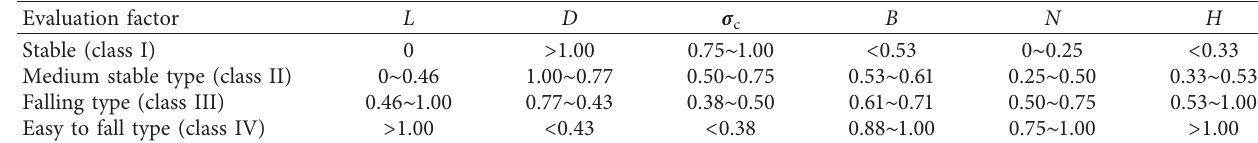
Table 3: The roof stability type and the standardized data of each index evaluating